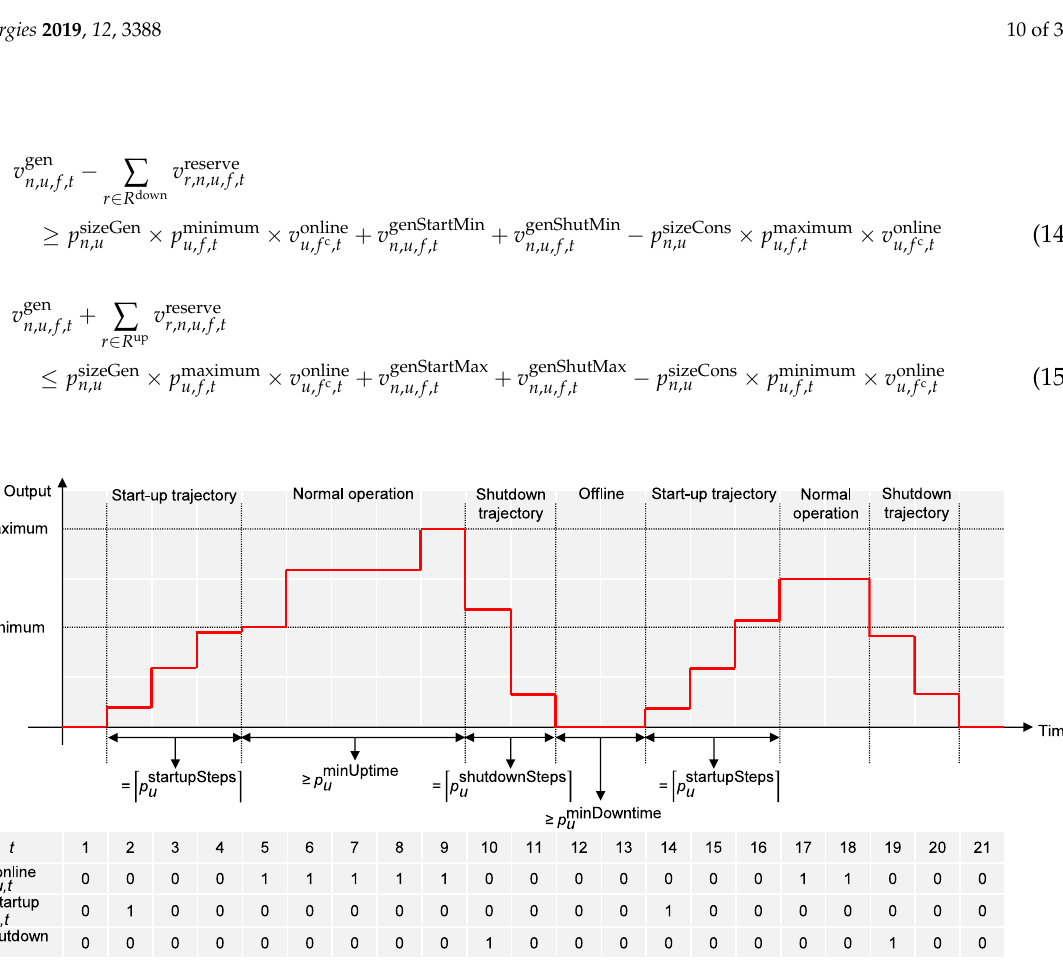
Figure 4. Start-up and shutdown logic of units. (cid:100) p startupSteps